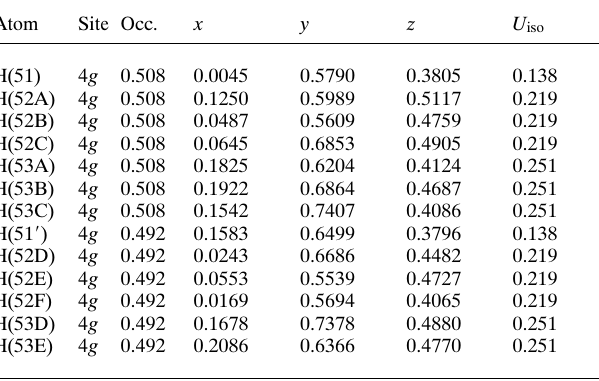
Table 2. Atomic coordinates and displacement parameters (in Å 2 ) .